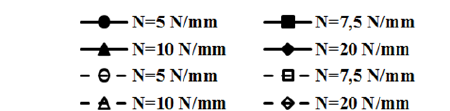
Figure 5. Influence of the radial clearance and the load on the contact